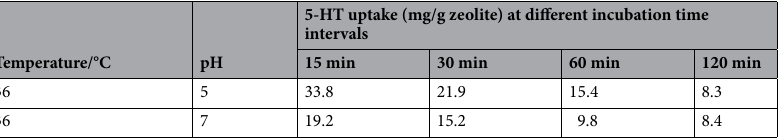
Table 3. 5-HT uptake capacity of DETOXSAN in relation to temperature and pH value. 5-HT uptake samples: 1 g of zeolite (particle size 40 µm), 100 ml of double distilled water (pH 7) or 0.00001 M HCl in 100 ml of double distilled water (pH 5), respectively, 25 mg of 5-HT, temperature = 36 °C. The TG measurements were conducted between 350 and 600 °C.